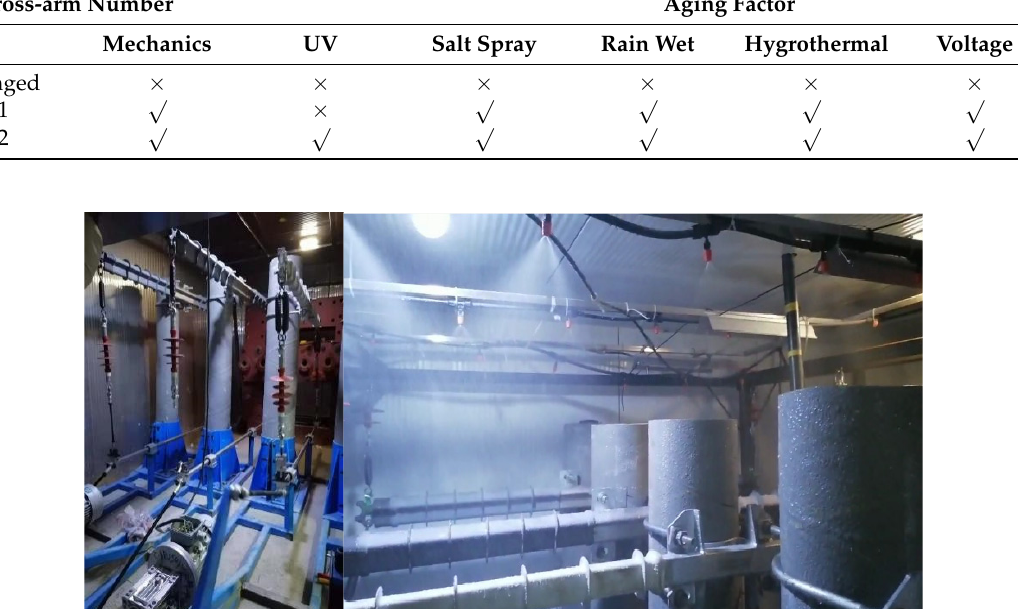
Table 3. Multi-factor Aging Subsystem Design Parameters.